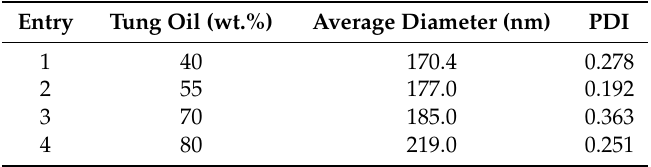
Figure 11. STEM images of a cured sample suspension containing 200 mg of total monomer weight with 40 wt.% of tung oil at ( A ) 30,000× magnification, ( B ) 85,000× magnification, and ( C ) 40,000× magnification. All scale bars correspond to 100 nm, while white arrows indicate vesicles. Table 2. Zetasizer results for cured emulsions containing 200 mg of total monomer weight with 40–80 wt.% of tung oil.